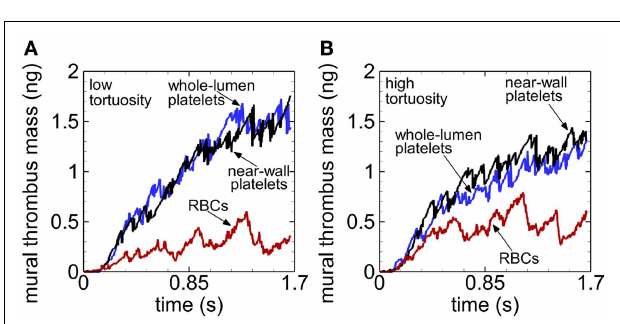
FIGURE 7 |Thrombus formation at t = 1.54s for different seeding scenarios, including whole-lumen-seeded platelets ( top ), near-wall-seeded platelets ( middle ), and RBCs with platelets ( bottom ), for small platelets (A) and large platelets (B), for the high tortuosity arteriole for Cases 7–12 . Cells include activated platelets ( black ), unactivated platelets ( white ), and red blood cells ( red